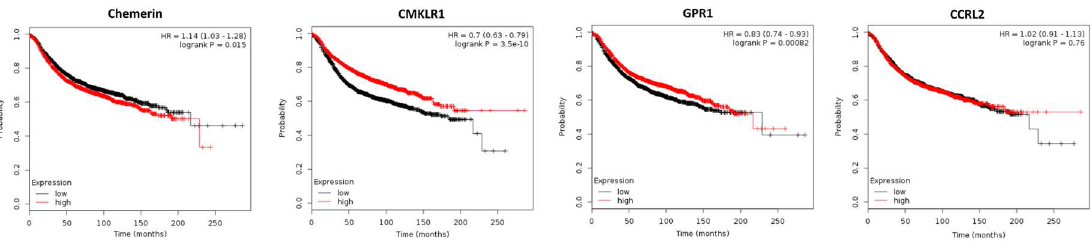
Figure 2. Kaplan–Meier diagrams showing the relapse-free survival (RFS) of 3951 breast